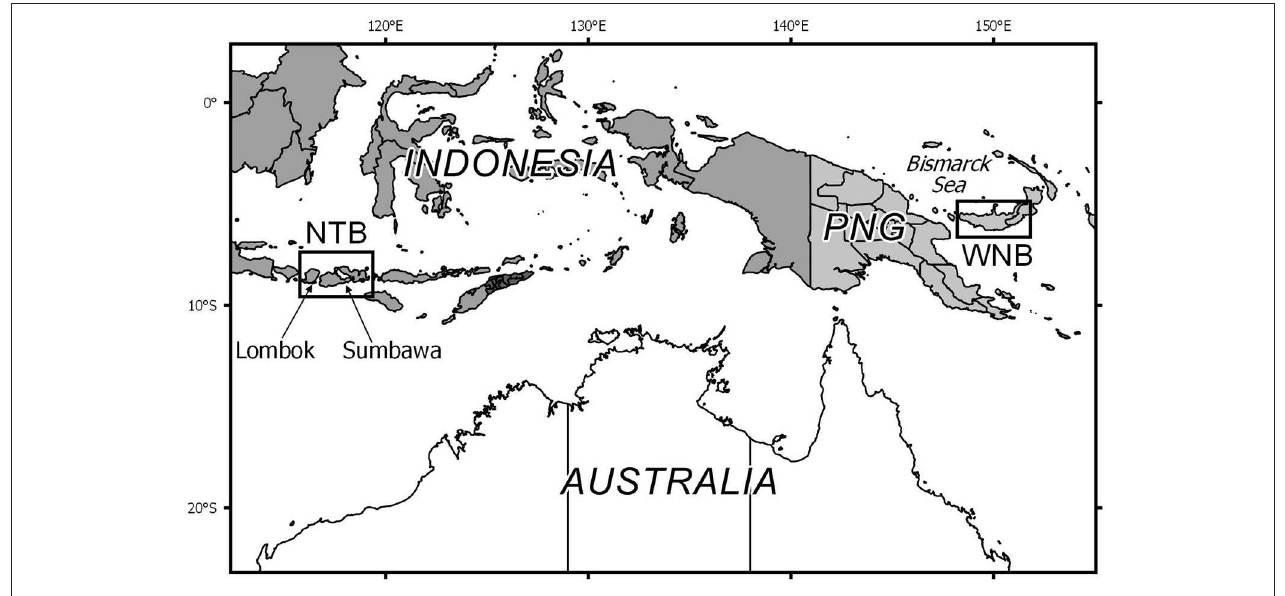
FIGURE 1 | The locations of Nusa Tenggara Barat (NTB) Province in Indonesia, and West New Britain (WNB) Province, Papua New Guinea